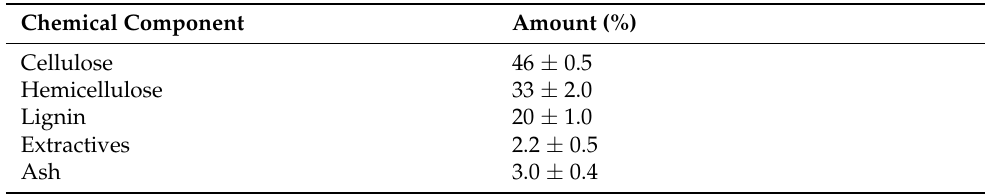
Table 1. Chemical composition of